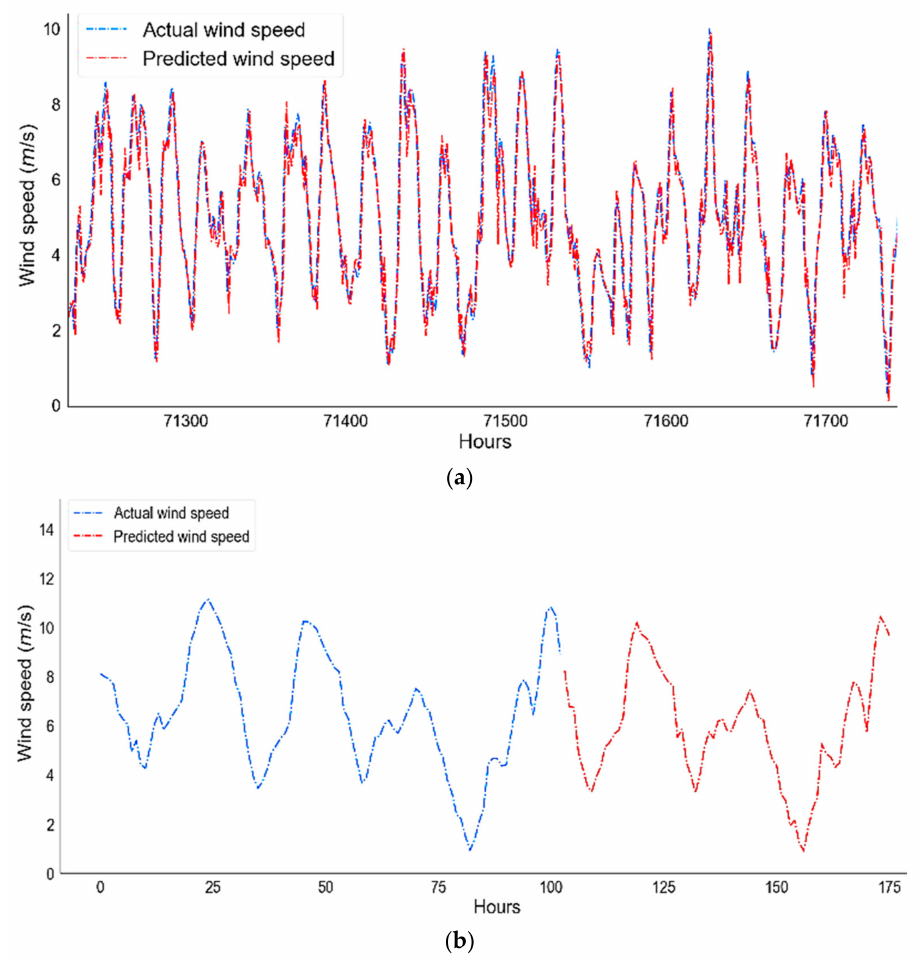
Figure 21. ( a ) The real and predicted values of wind speed, which show the fit and performance of the BI-LSTM model; and ( b ) the wind speed’s predicted future values for the next 169